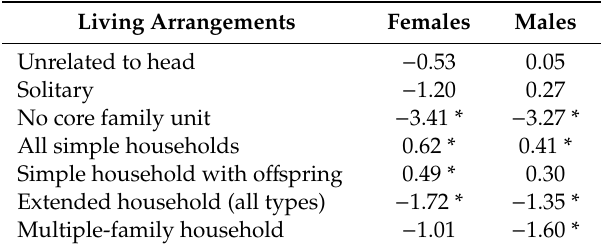
Table 2. Results of binary regression of percentages of those aged 60 years and over receiving payments under the New Poor Law in 1891 on the percentages of those aged 30–59 years in 1861 living under various arrangements: 63 registration districts / Poor Law Unions of England and Wales. Living Arrangements Females Males Unrelated to head − 0.53